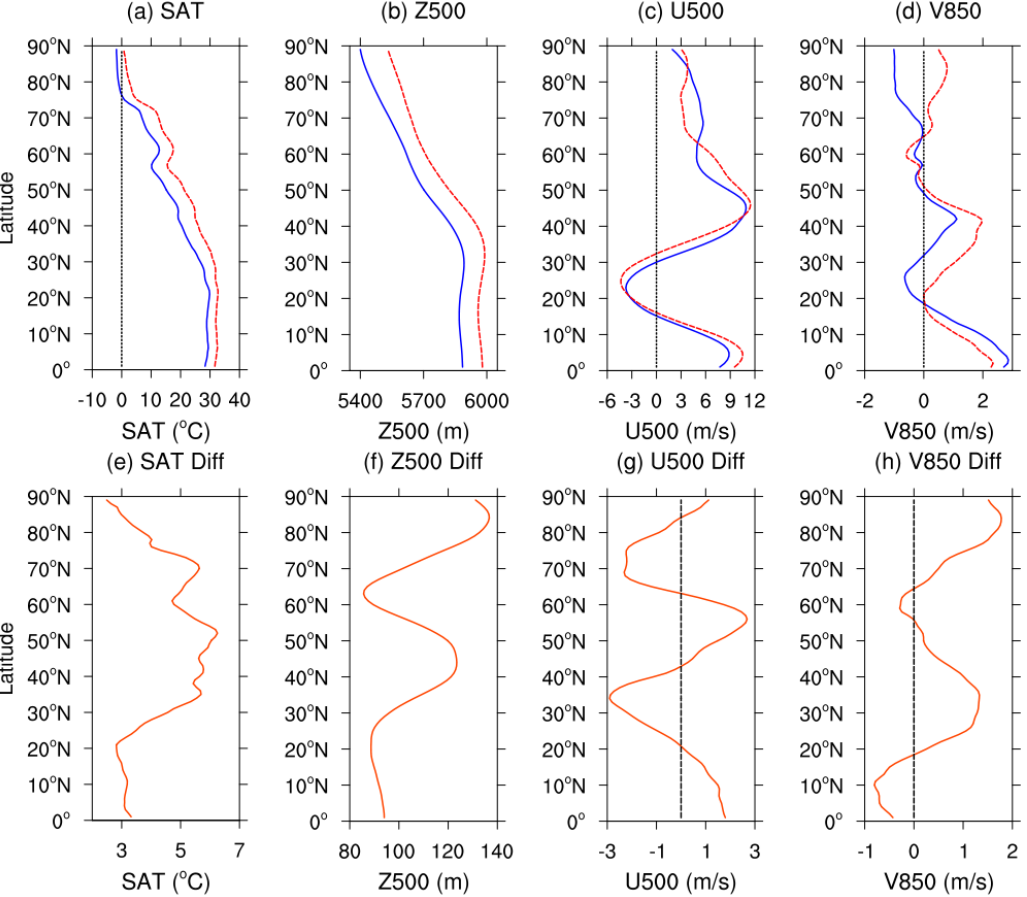
Figure 9. Averages of the different variables for each latitude: ( a ) SAT (°C), ( b ) Z500 (m), ( c ) U500 (m / s), ( d ) V850 (m / s). Future changes for ( e ) SAT (°C), ( f ) Z500 (m), ( g ) U500 (m / s), ( h ) V850 (m / s).